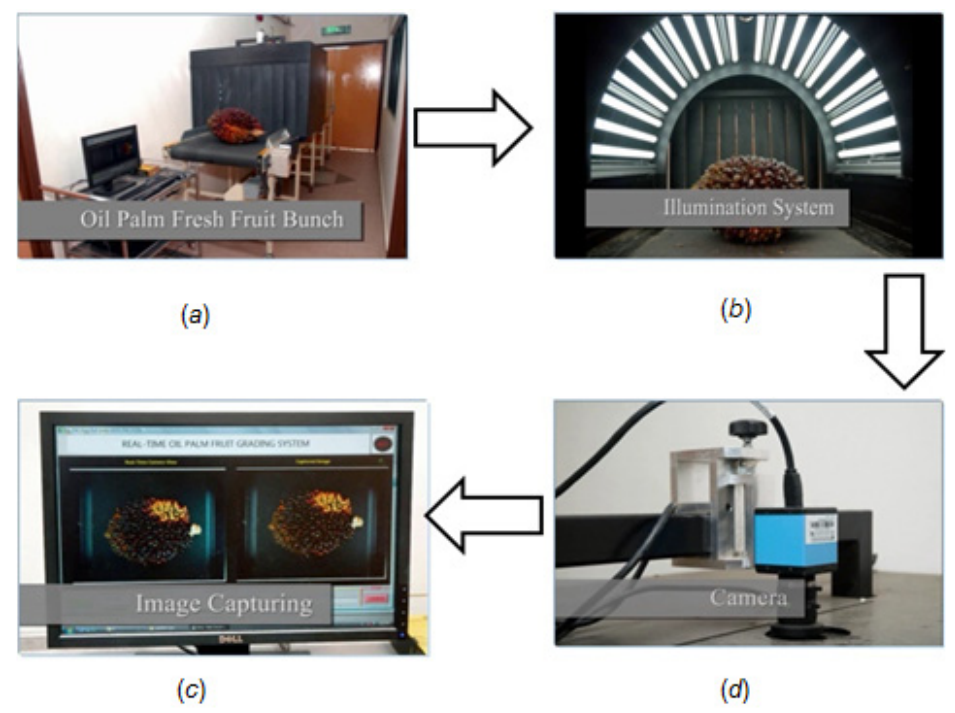
Figure 3. Process of acquiring materials and images: ( a ) oil palm grading system, ( b ) lighting system, ( c ) captured image, ( d ) camera and RGB cable.